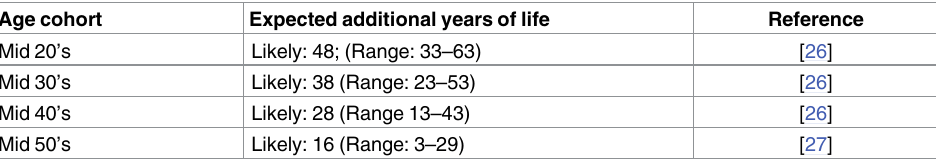
Table 1. Expected additional years of life of patients with MDD in the age cohorts evaluated in the